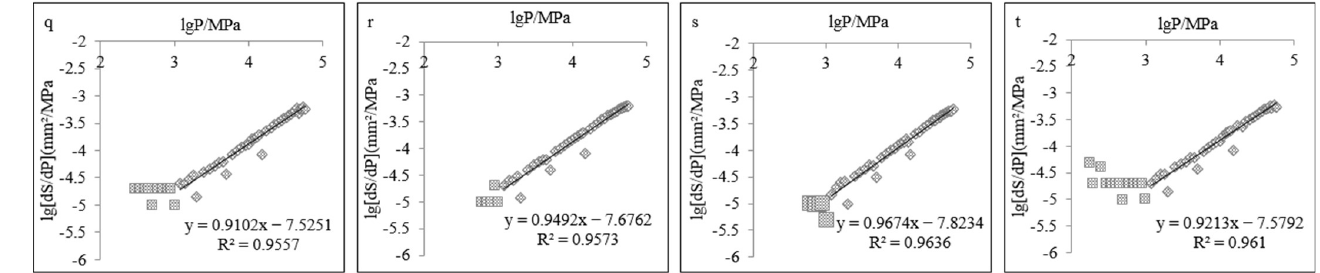
Figure 6. Plots ( a – t ) of the volume increment in fixed stress ( dV/dP ) and pressure ( P ) in the double logarithm coordinates corresponding to coal samples M1-M20.